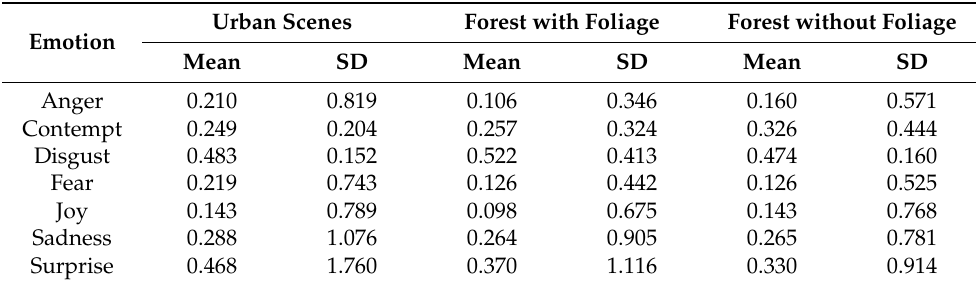
Table 2. Results from one-way repeated measures ANOVAs for individual emotional categories. Emotion df F p Anger 2, 128 1.112 0.332 Contempt 2, 128 1.558 0.214 Disgust 2, 128 0.728 0.485 Fear 2, 128